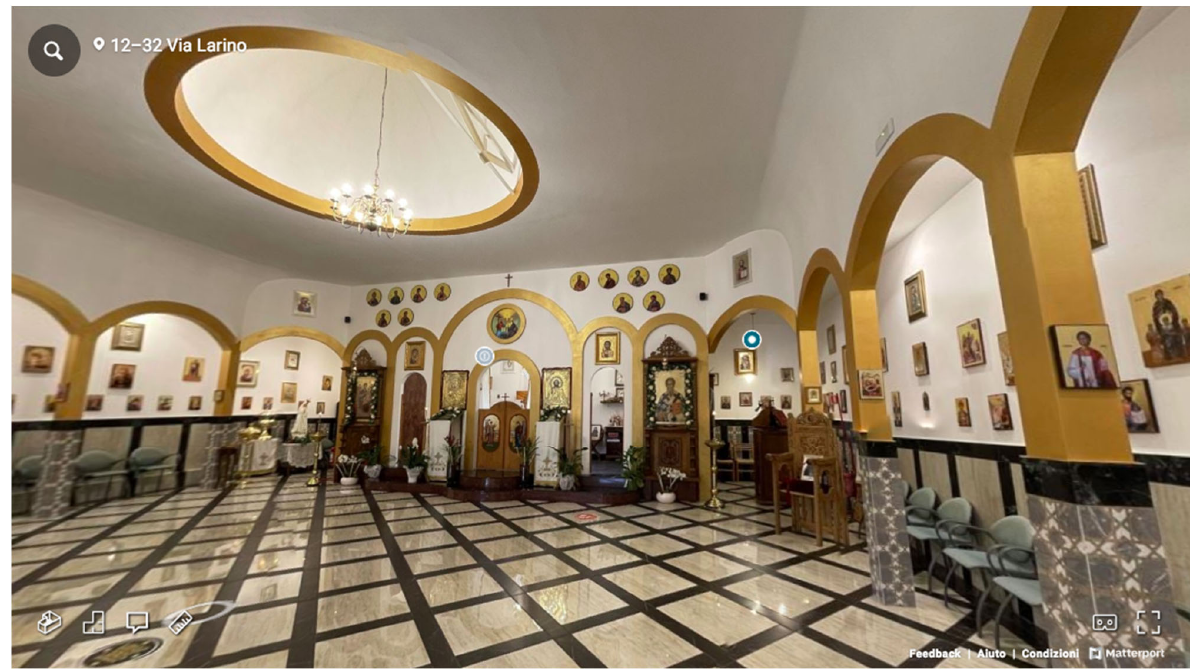
Figure 7. Church interior with matter